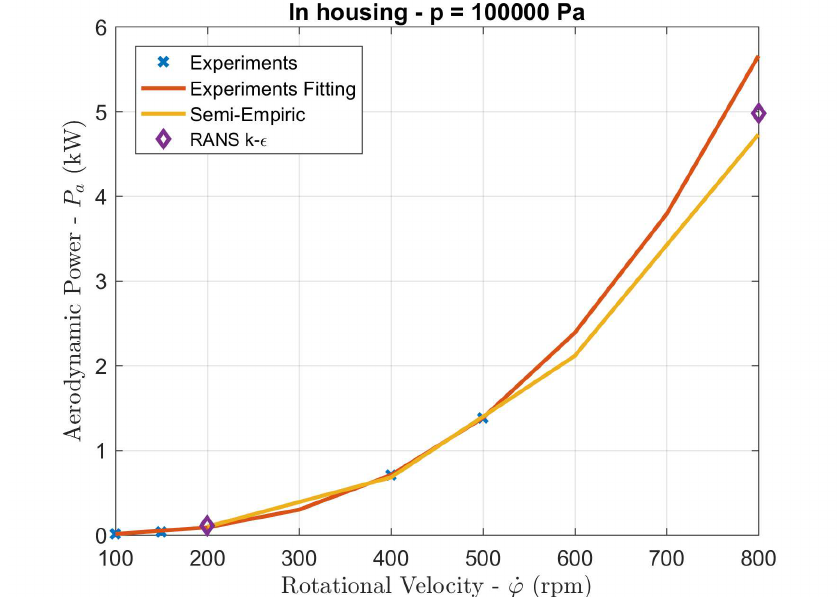
Figure 16. Aerodynamic power: In housing configuration results comparison against available experimental